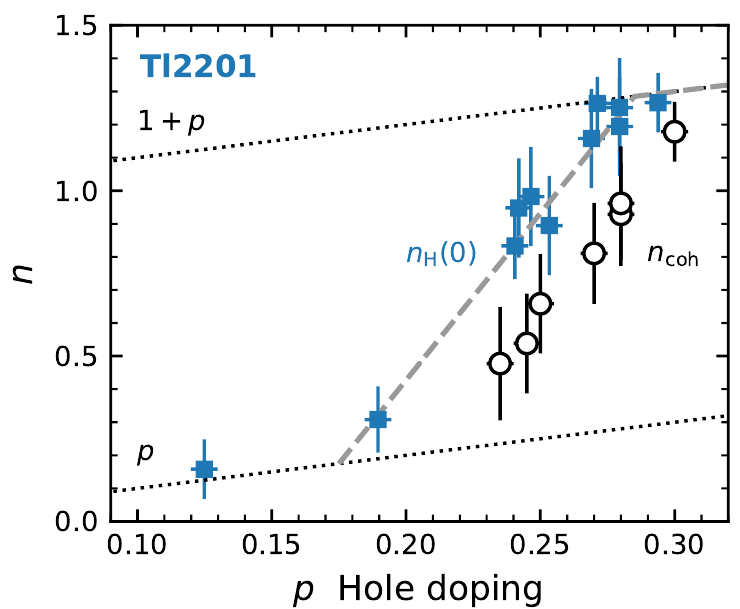
( 0 ) in OD Tl2201 [ 14 ] together with the Figure 4: Measured Hall carrier density n H coherent carrier density n in the zero-temperature limit extracted using Eq. (16). coh In order to obtain n , the Hall data [ 14 ] (blue squares) are first fitted to the faint coh ( 0 ) = 0.175 + 10.1 ( p − 0.175 )) . Then, for each p value for which dashed line ( n H